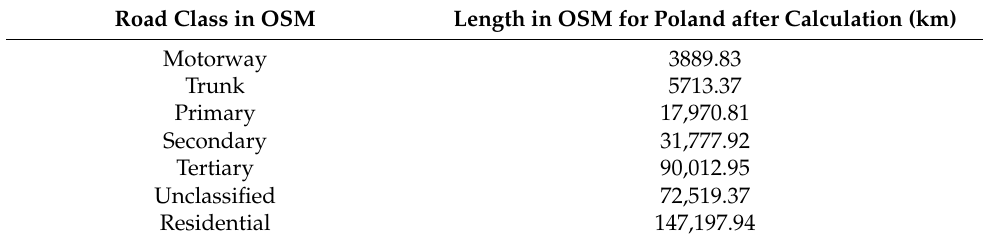
Table 1. OSM road classes with their length for